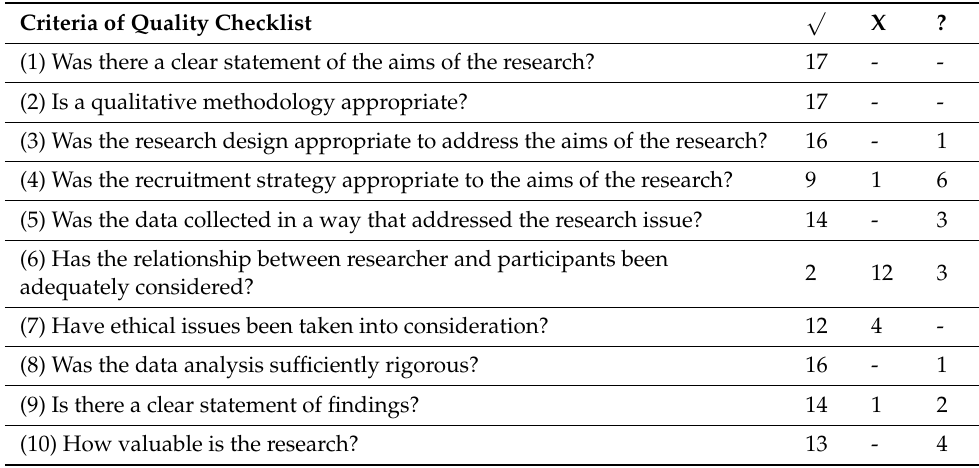
Table A3. Results of quality